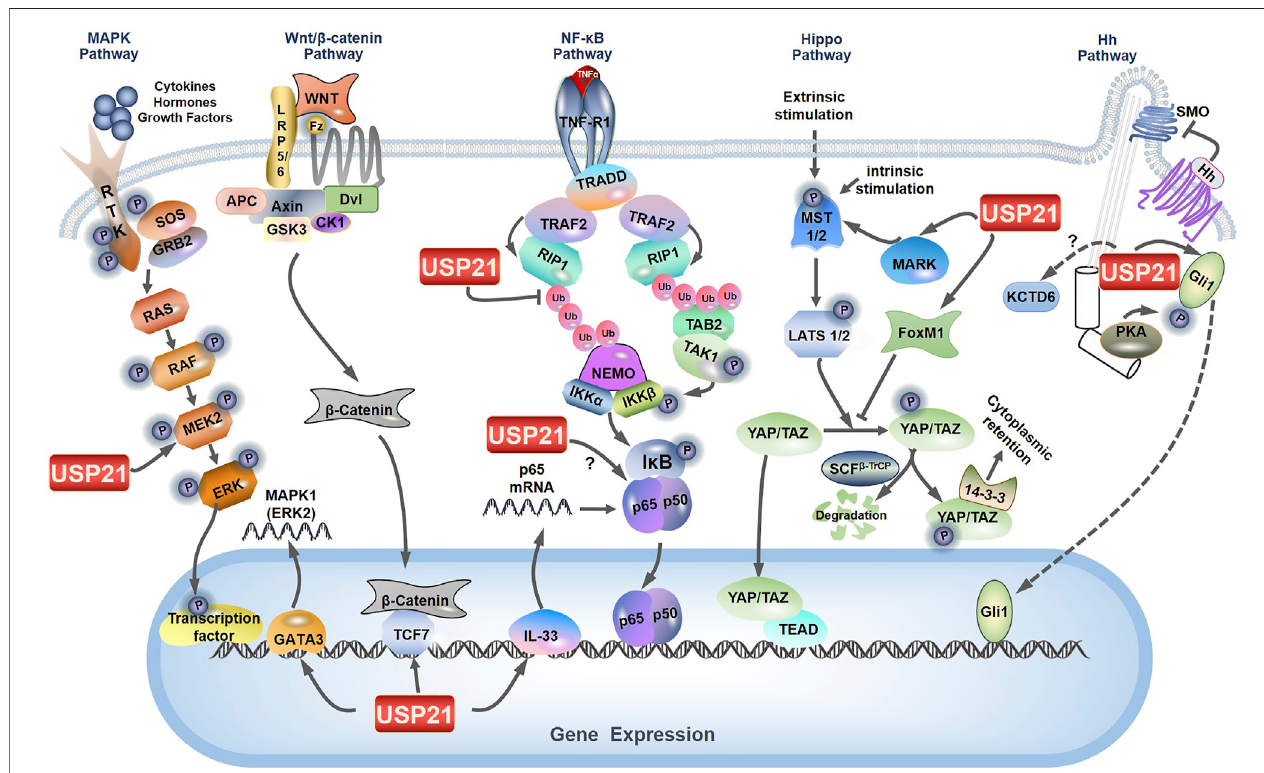
FIGURE 3 | Role of USP21 in multiple signaling pathways. The fi gure depicts the key components and signal transduction cascade reactions in MAPK/ERK signaling, NF- κ B signaling, Wnt/ β -catenin signaling, Hippo signaling, and Hh signaling. The nodes regulated by USP21 are labeled.